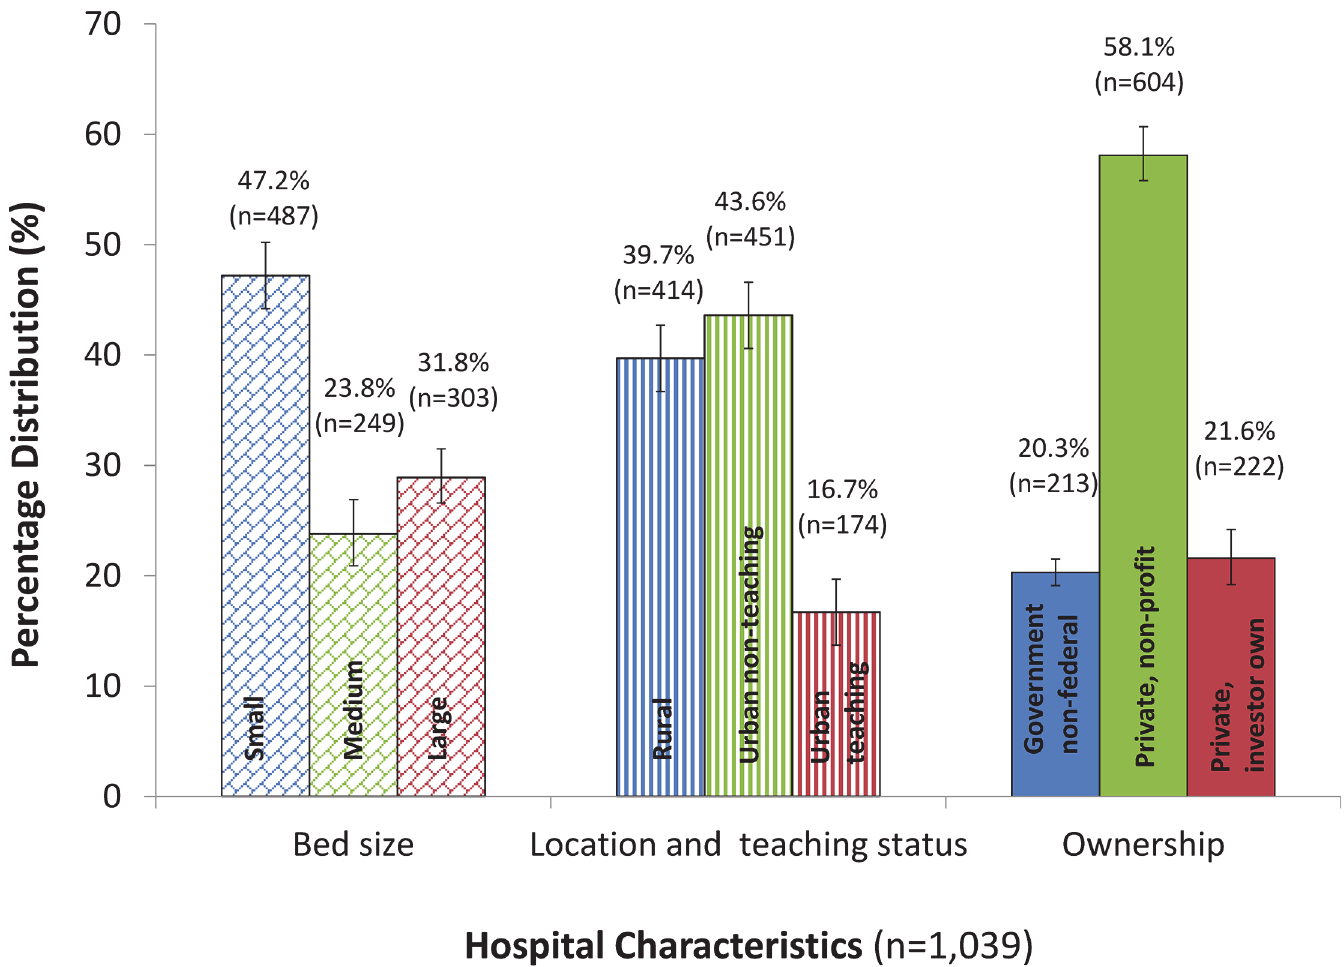
Fig 1. Number and percentage distributions of hospitals (n = 1,039) by hospital characteristics, NIS, 2011.